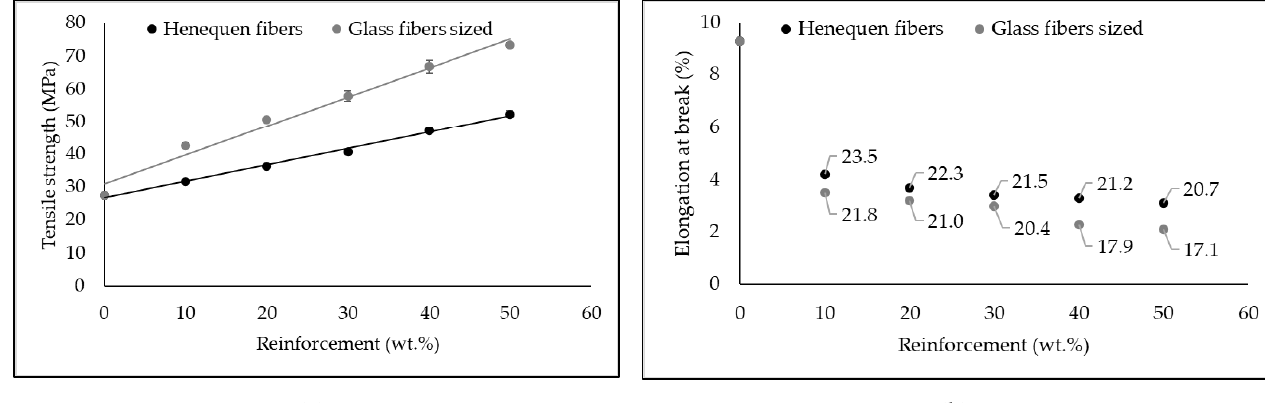
Figure 3. Comparison of tensile properties between Henequen fibers and glass fibers sized polypropylene composites: ( a ) Tensile strength properties of the composites; ( b ) Elongation at break of the composites and respective matrix stress at the breaking point of the composite value (data in the graph).